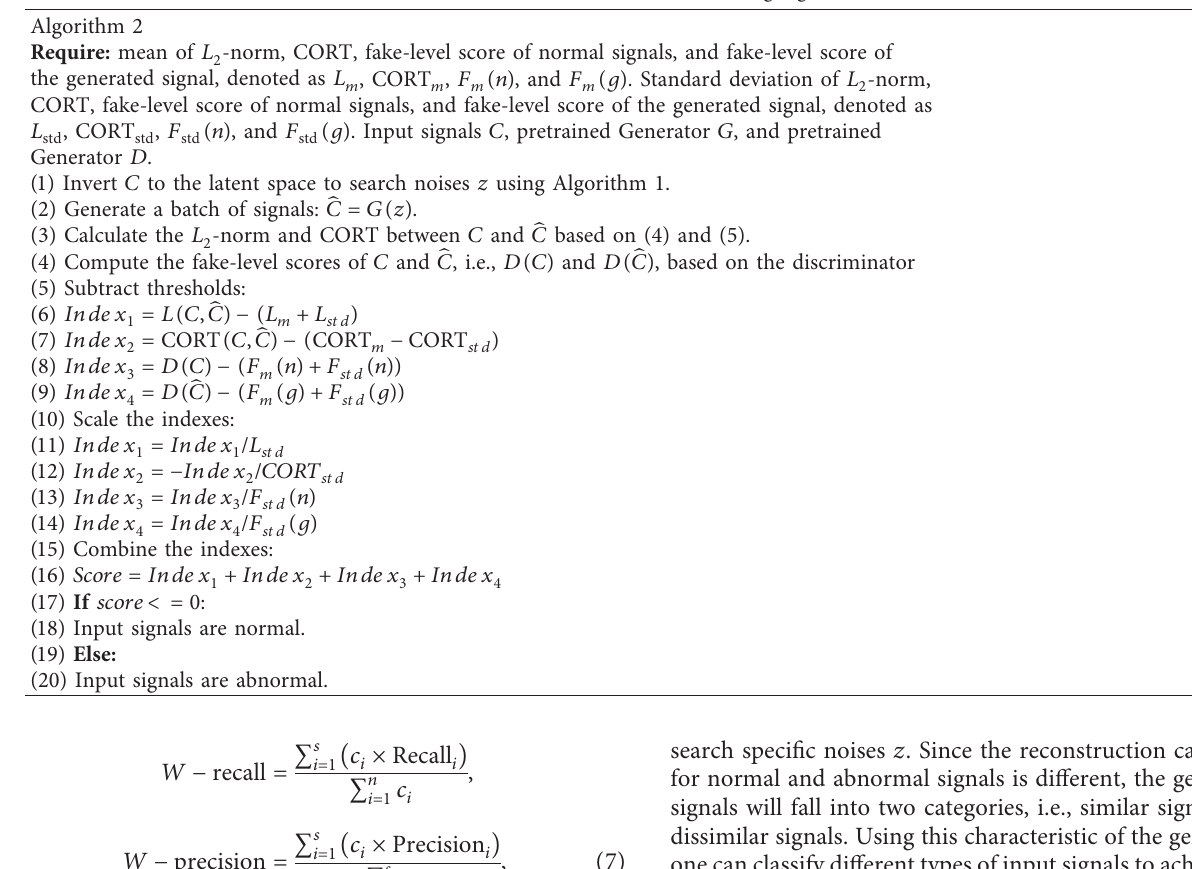
Table 2: Multi-index decision-making algorithm.